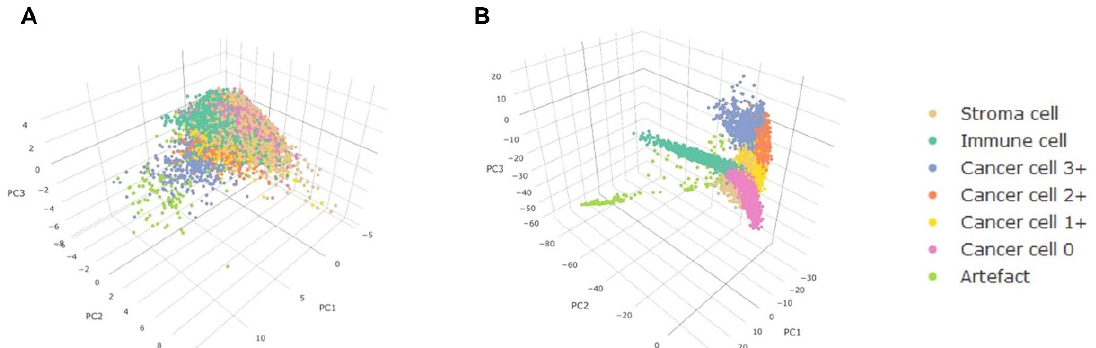
Figure 7. Principal Factor Review of the learned and hand-designed features. The point diagram displays the three primary component values of ( A ) the hand-designed features, and ( B ) the features learned from the convolution neural network. Reproduced with permission from [142].